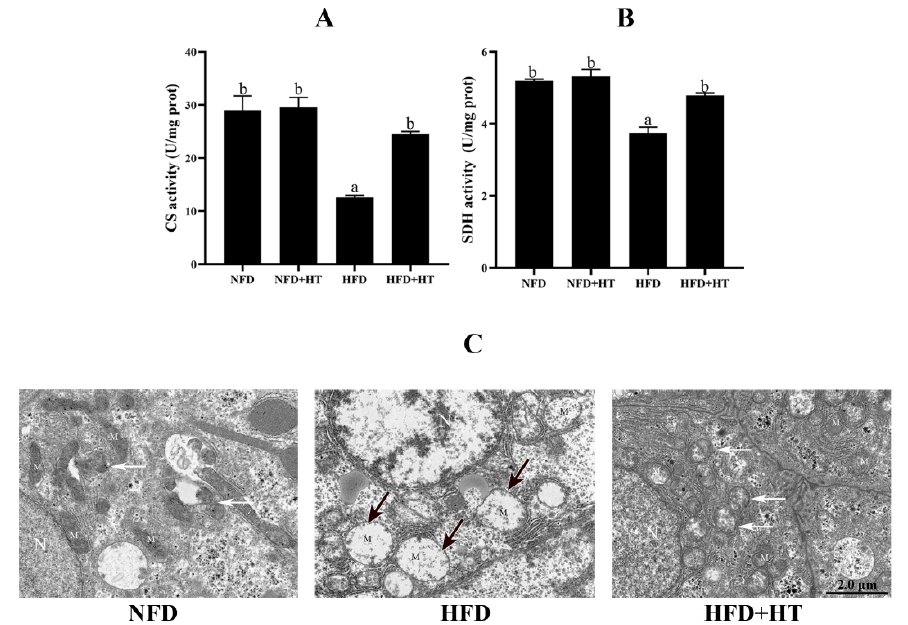
Figure 4. Citrate synthase (CS: ( A )) and succinate dehydrogenase (SDH: ( B )) activities and ( C ) transmission electron microscopy images of mitochondria (N—nucleus; M—mitochondrion; black arrows—damaged mitochondria; white arrows—mitochondrial autophagosomes) in the liver of L. maculatus fed the test diets for 8 weeks. All values are exhibited as mean ± SE. The values with different superscripts (a, b) are significantly different at p < 0.05 (Tukey’s test).